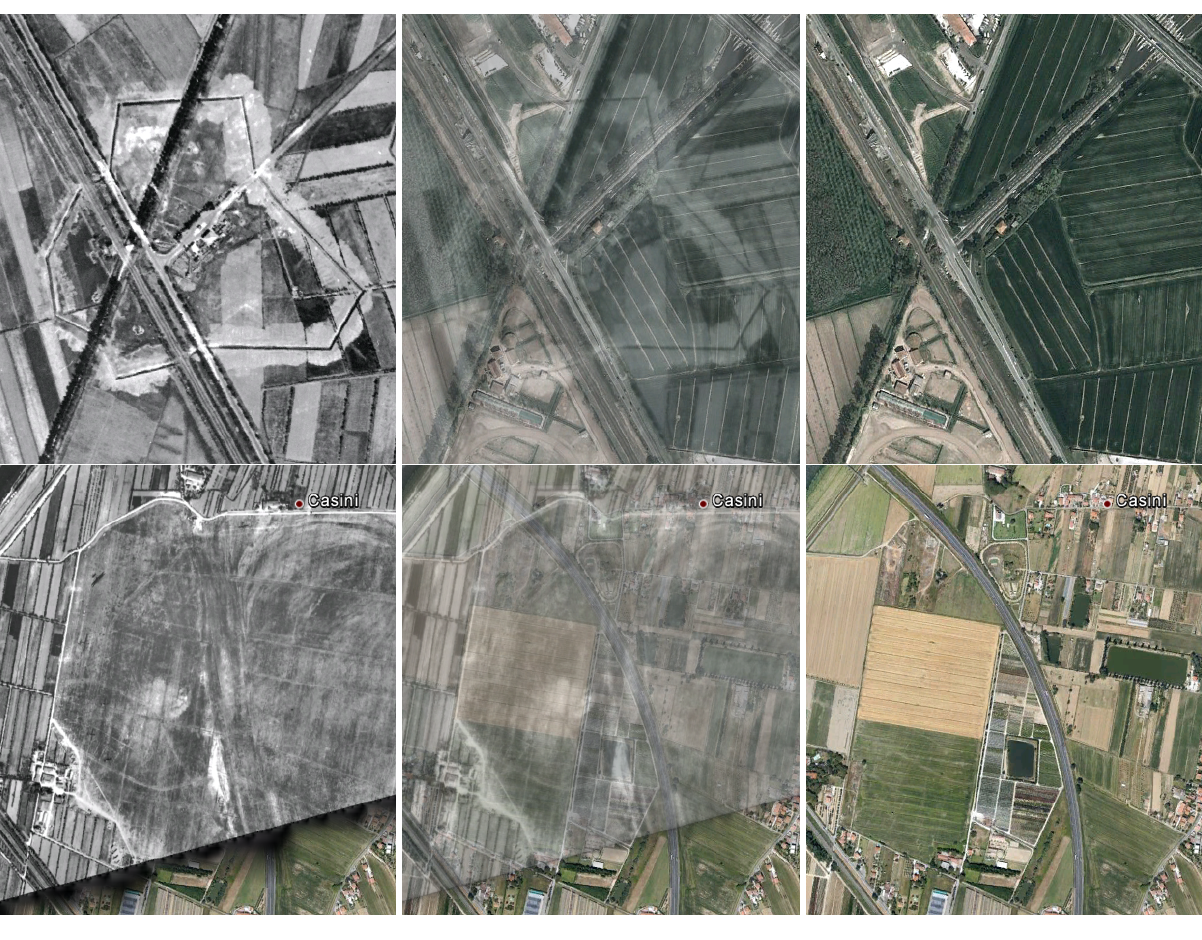
Figure 19. Two examples of historical evidences of World War II compared to recent imagery: a German fortification ( top ) and an airfield ( bottom ), where a Messerschmitt 323 Gigant airplane can be spotted in the upper-left corner ( c (cid:13) MiBAC-ICCD, Aerofototeca Nazionale, fondo RAF. c (cid:13) 2010